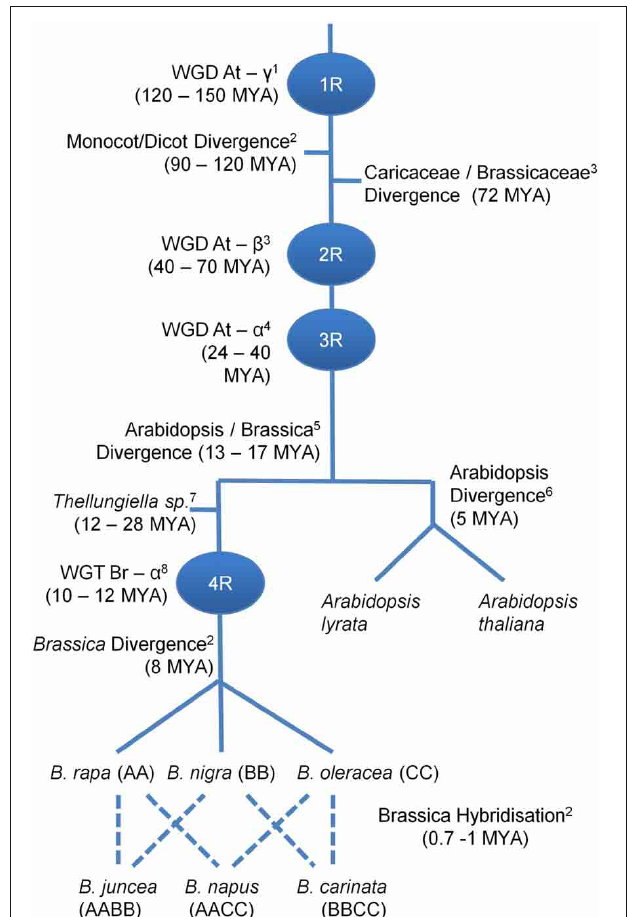
FIGURE 1 | Genome evolution of B. napus and A. thaliana. Prior to their divergence approximately 13–17 MYA B. napus and A. thaliana share a complex genome evolution including three (denoted 1R, 2R, and 3R) whole genome duplication (WGD) events. The last two WGD events post date the divergence of the Moncots/Dicots and the Caricaceae/Brassicaceae. Since their divergence the ancestor of extant Brassica species underwent a whole genome triplication event (WGT, denoted 4R) with the allopolyploid B. napus arising from the hybridization of B. rapa and B. oleracea . Superscript numbers relate to references for divergence times. For an in depth analysis of evolutionary history of Brassicaceae please refer to the excellent review by Franzke et al. (2011). 1 (Soltis et al., 2009); 2 (Mun et al., 2009); 3 (Bell et al., 2010); 4 (Henry et al., 2006); 5 (Yang et al., 1999); 6